Question: Sum up the contents of this chart in one sentence.
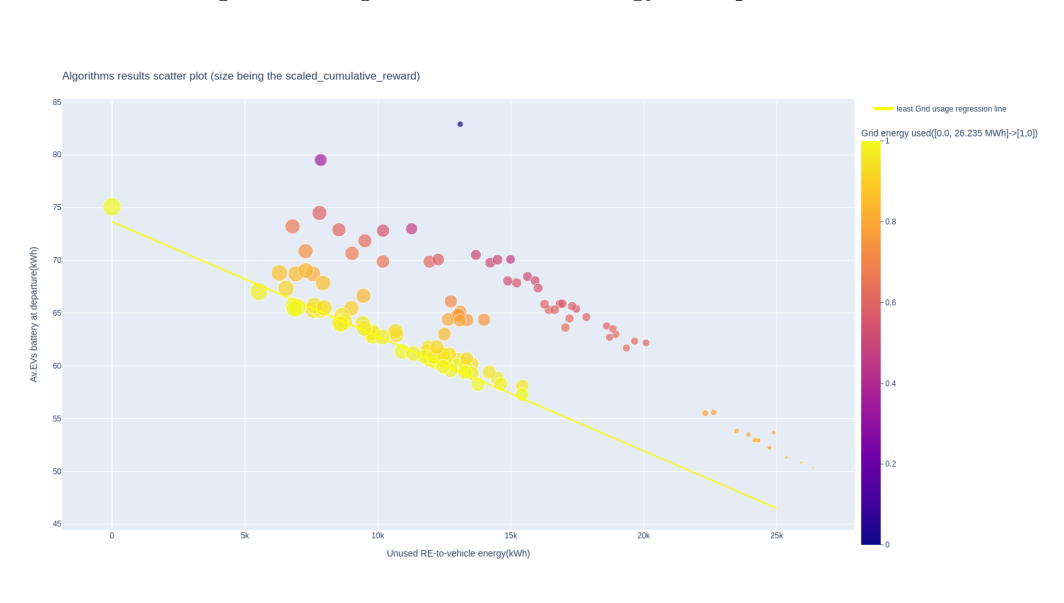
Answer: 3: Algorithms results 3D plot, with color scale mapped to cumulative reward.